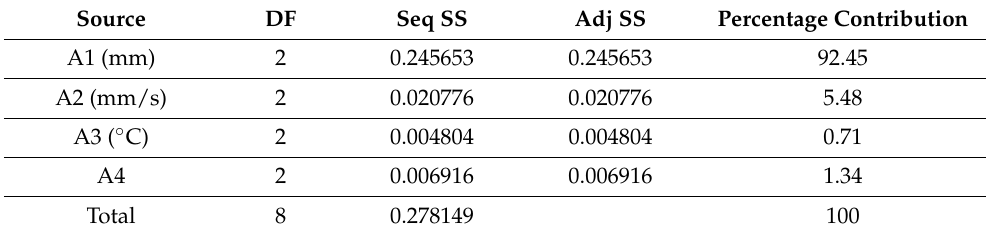
Table 10. ANOVA Table for the Rq-PA-6 polymer.